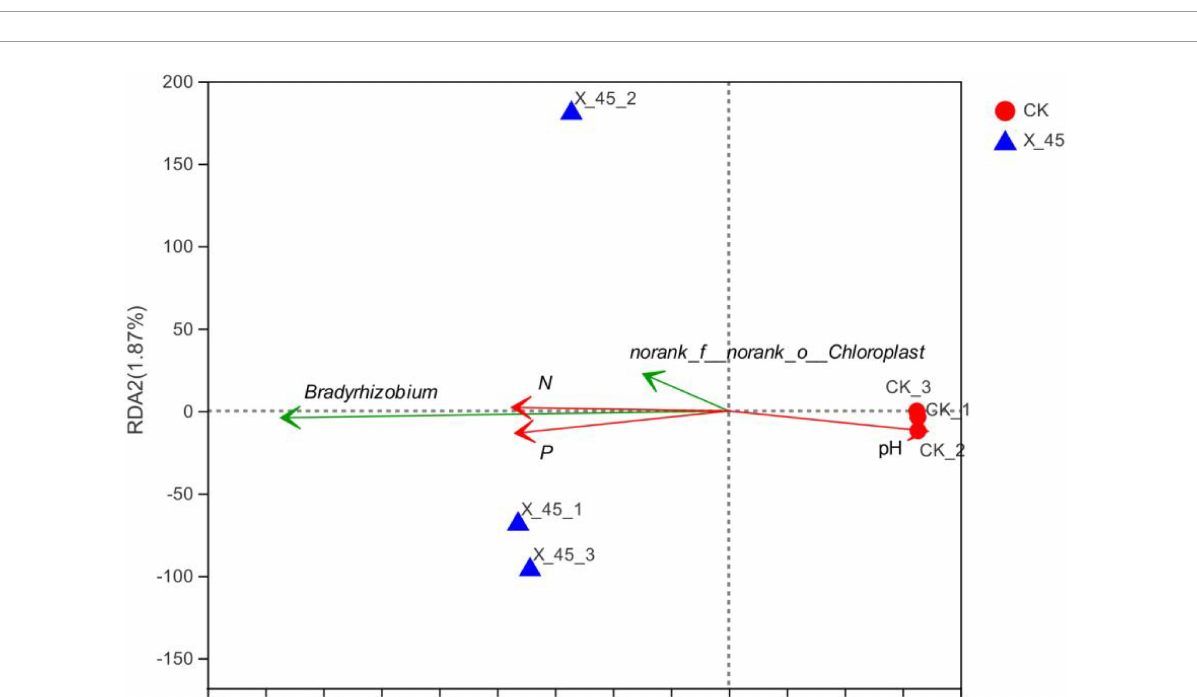
FIGURE6 Student’s t -test bar plot on genus level with 95% confidence intervals.